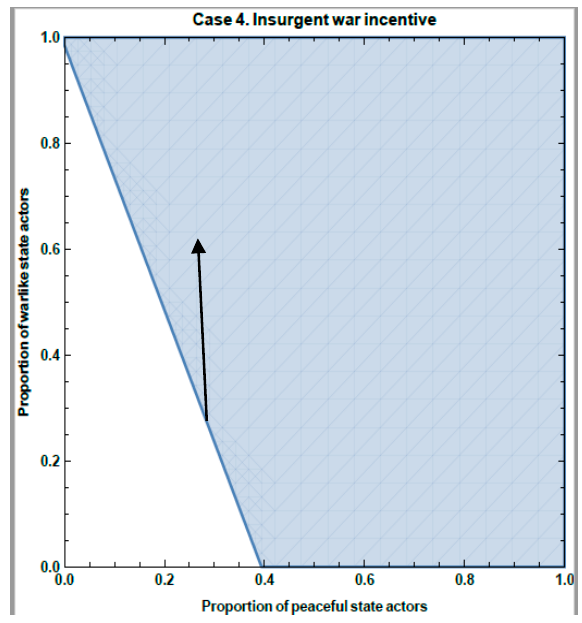
Figure 7. Fitness for Insurgents when r = 0.5, δ = 0.99, c = 0.2, p = 0.5.